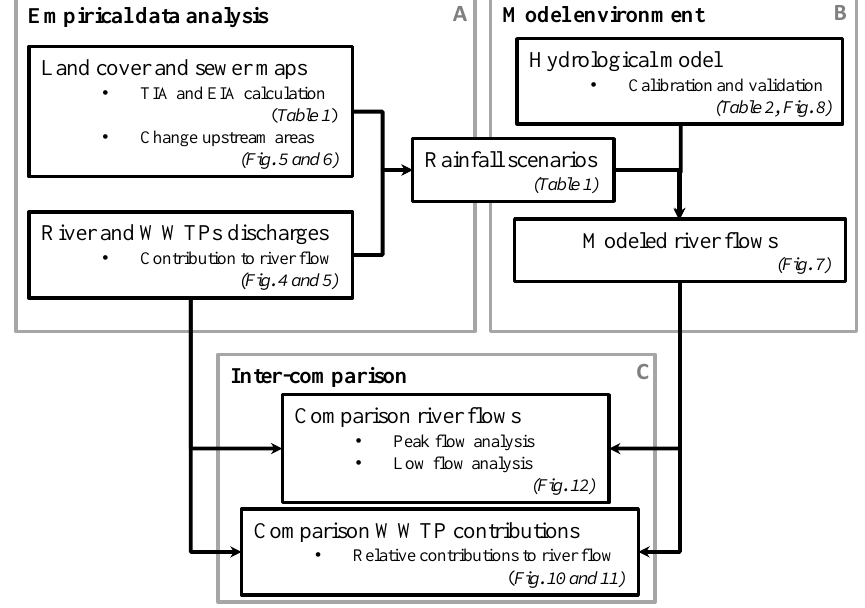
Fig. 1. General overview of the different steps of the research methodology and their